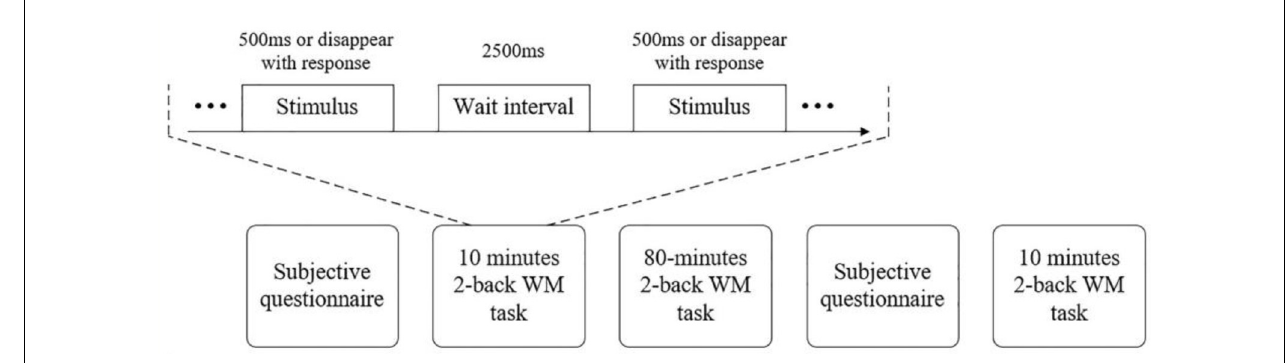
FIGURE 1 | The procedure.